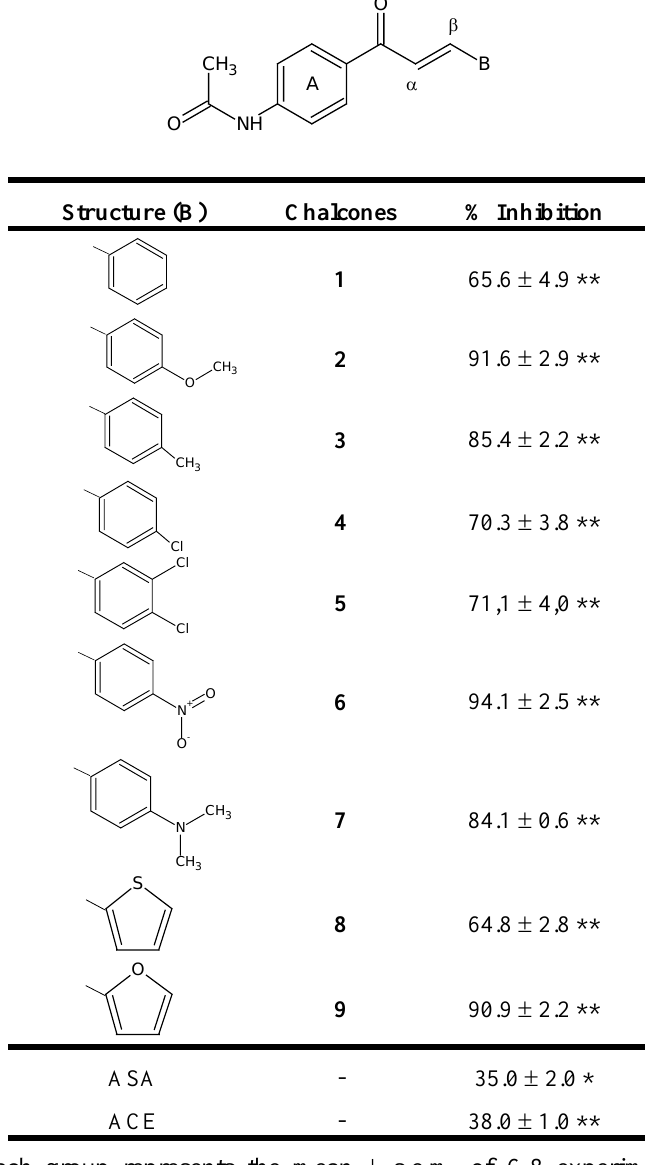
Table 1. Antinociceptive activity of 4’-acetamidochalcones, acetylsalicylic acid (ASA) and acetaminophen (ACE) against acetic acid-induced abdominal constrictions in mice.